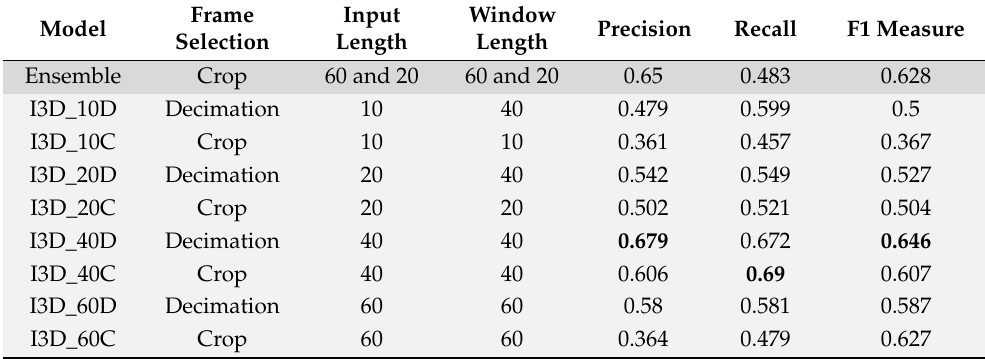
Table 6. Action localization results for I3D models with varying number and selection of frame and ensemble of I3D binary models with crop frame selection strategy. The best results of action localization are presented in